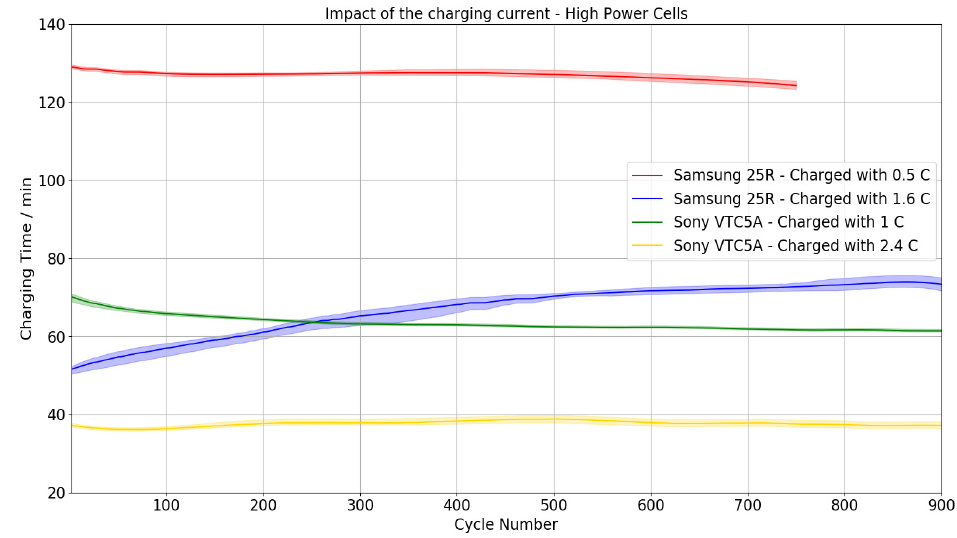
Figure 5. Development of the charging times during the cycle test of the high-power cells. Solid lines represent the mean values, shaded areas represent the spread of the measured values.